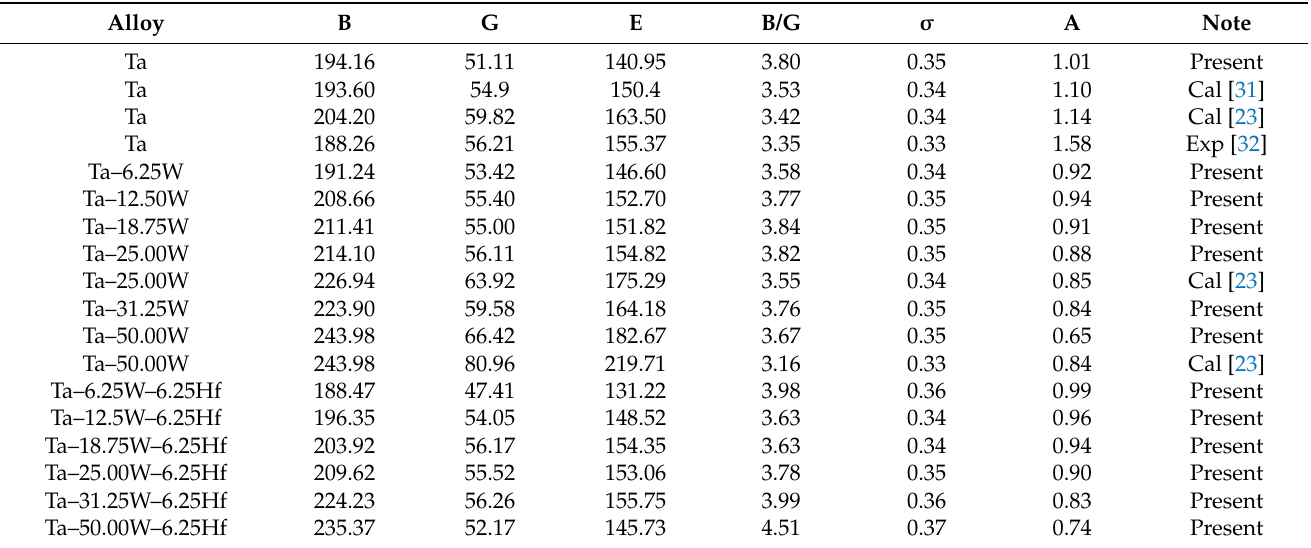
Table 4. The calculated elastic constants of Ta–W alloys and Ta–W–Hf alloys with different W content (unit: